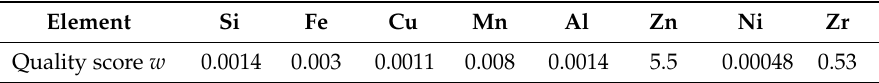
Table 2. ZK60 magnesium alloy chemical composition